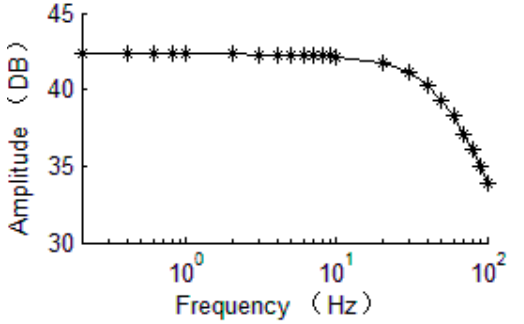
Figure 20. Amplitude–frequency characteristic curve of the original model.